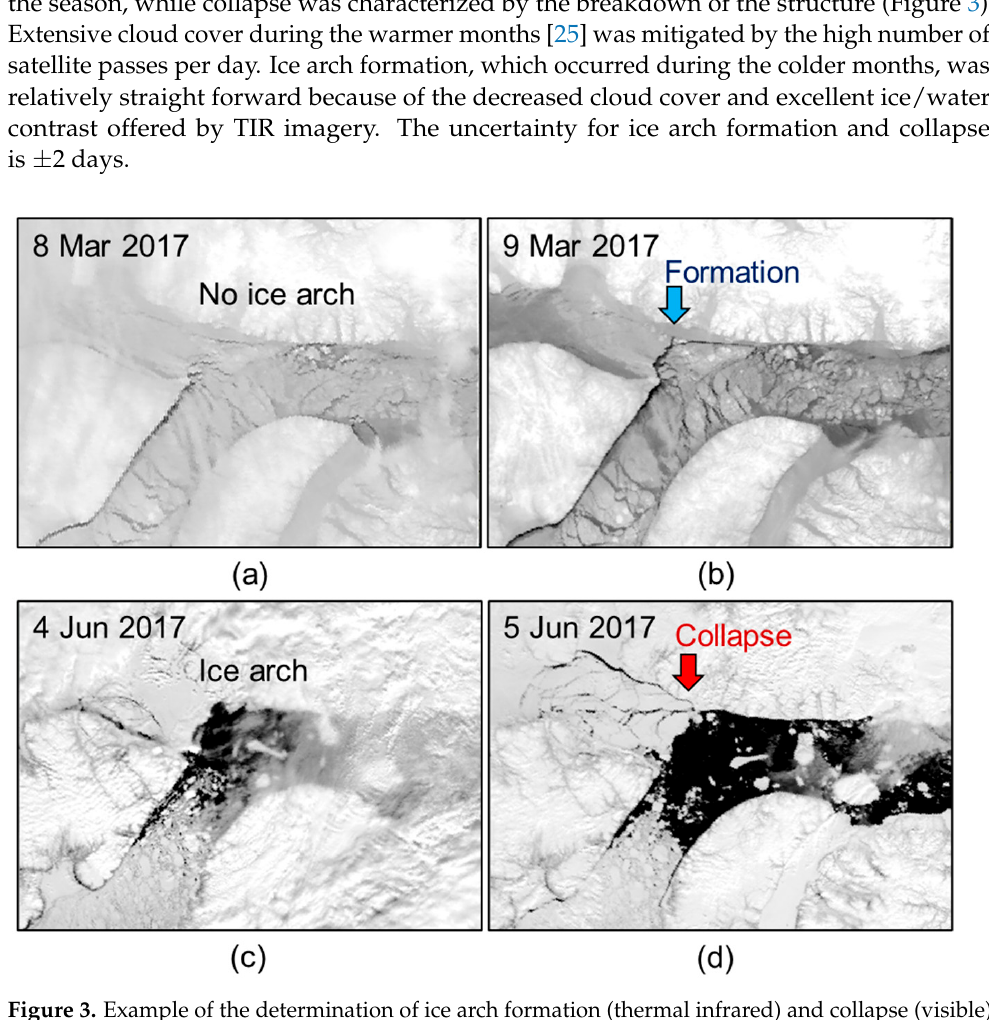
Figure 3. Example of the determination of ice arch formation (thermal infrared) and collapse (visible) in Lancaster Sound. ( a ) On 8 March 2017, the ice arch is not apparent. ( b ) The following day, the ice arch has formed. ( c ) The characteristic shape is maintained until 4 June 2017. ( d ) The ice arch collapses the following day.